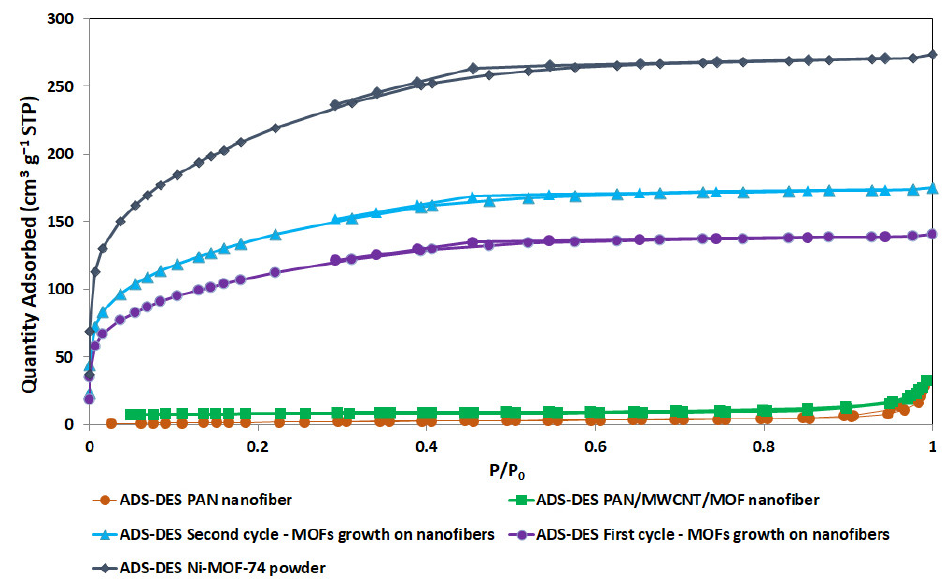
Figure 11. Nitrogen adsorption–desorption isotherms for PAN-based nanofibers loaded with different percentages of MOF/MWCNT and MOF powder.